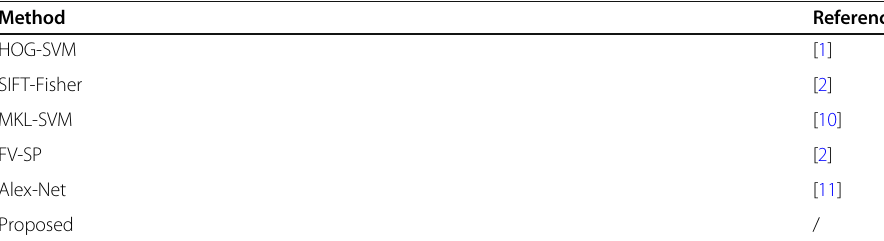
Table 1 The comparison of different